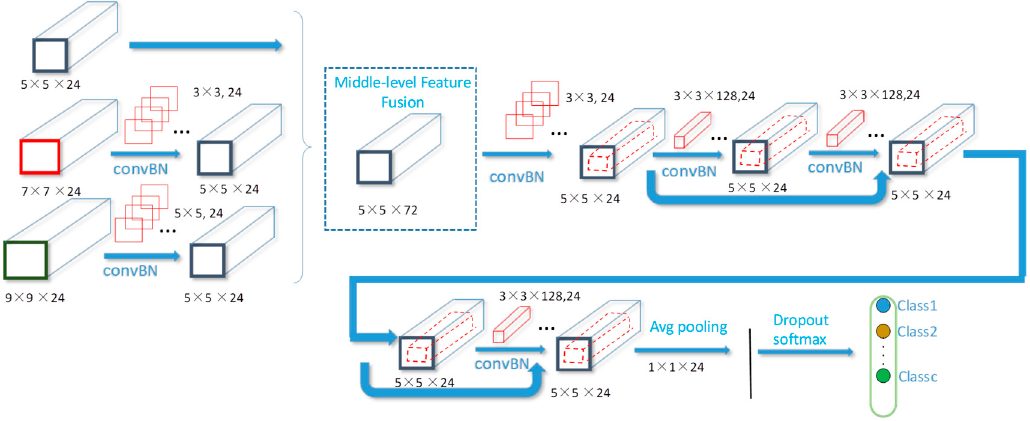
Figure 3. The framework of second training stage in MMFN.